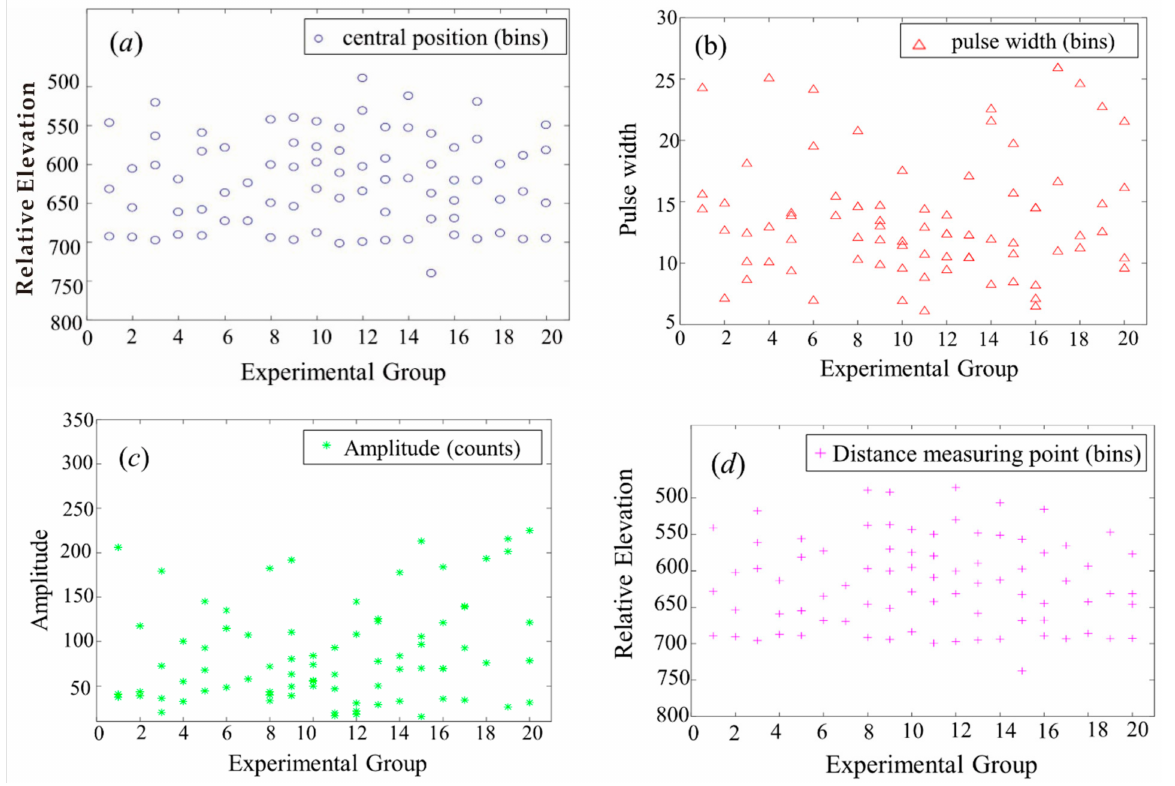
Figure 14. LiDAR echo decomposition results in Congo: ( a ) Central position; ( b ) Pulse width; ( c ) Amplitude; ( d ) Distance measuring